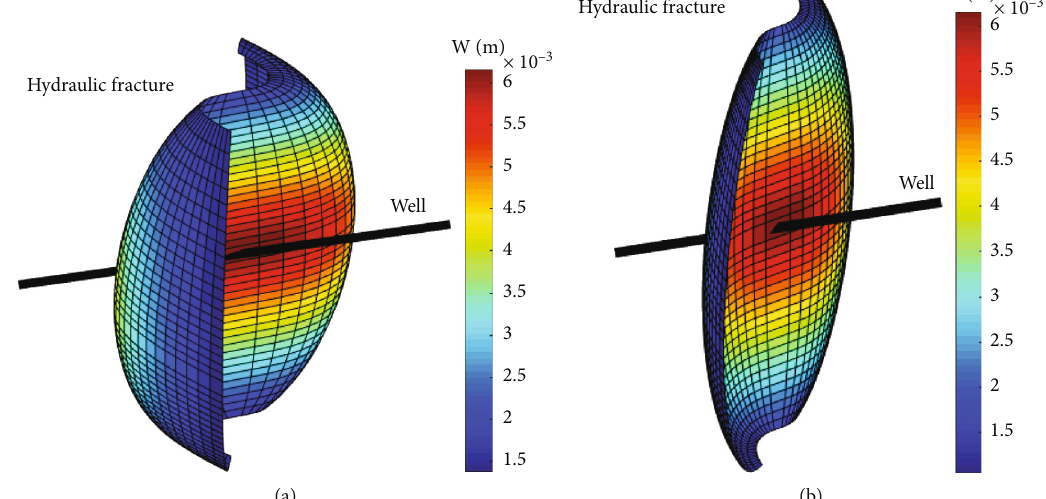
Figure 5: Spatial morphology of hydraulic fractures: (a) case 3; (b) case 5.